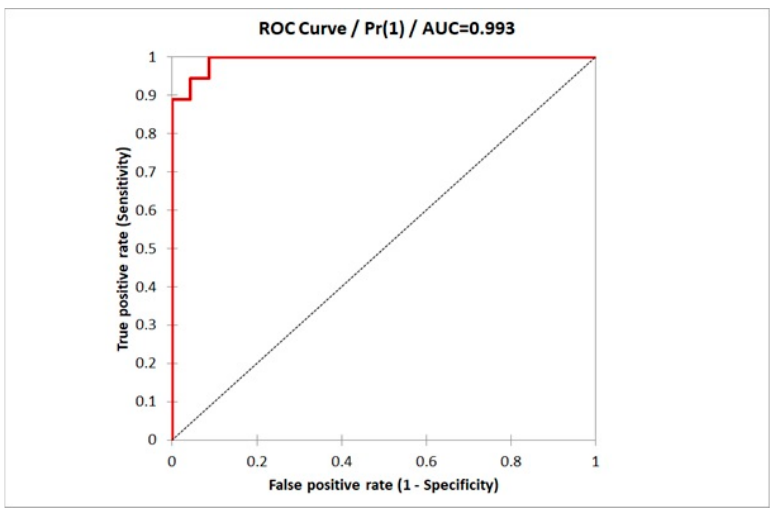
Figure 3. The ROC curve analysis for diagnostic efficacy of fibronectin in plasma for endometriosis.